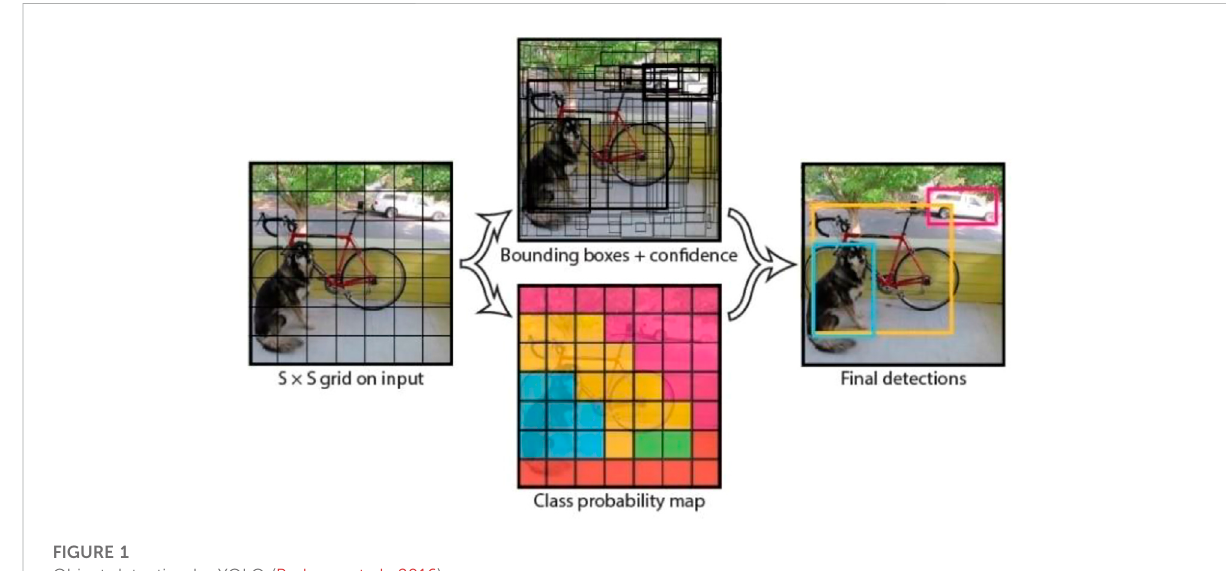
FIGURE 1 Object detection by YOLO (Redmon et al., 2016).